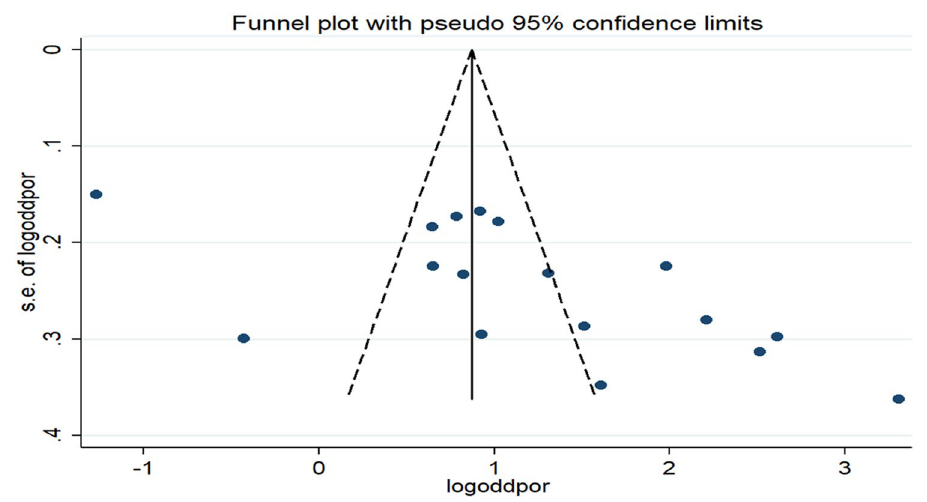
Figure 6. Funnel plot of the pooled odds ratio of watching pornography among young Ethiopia,